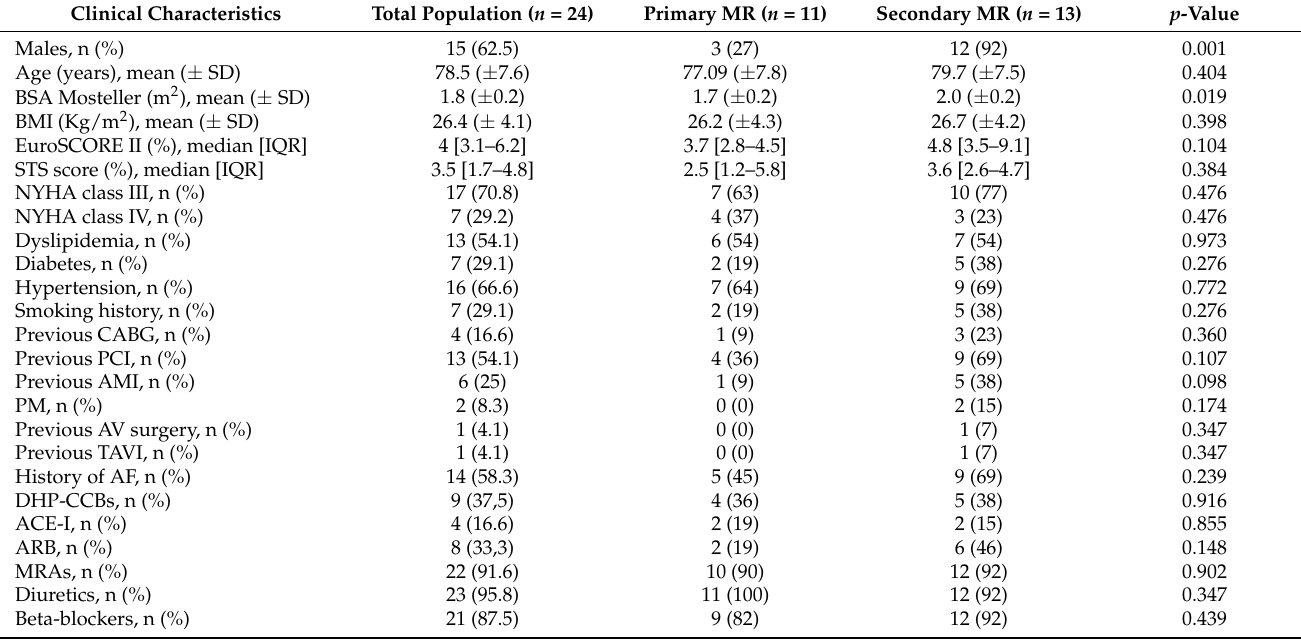
Table 1. Baseline clinical